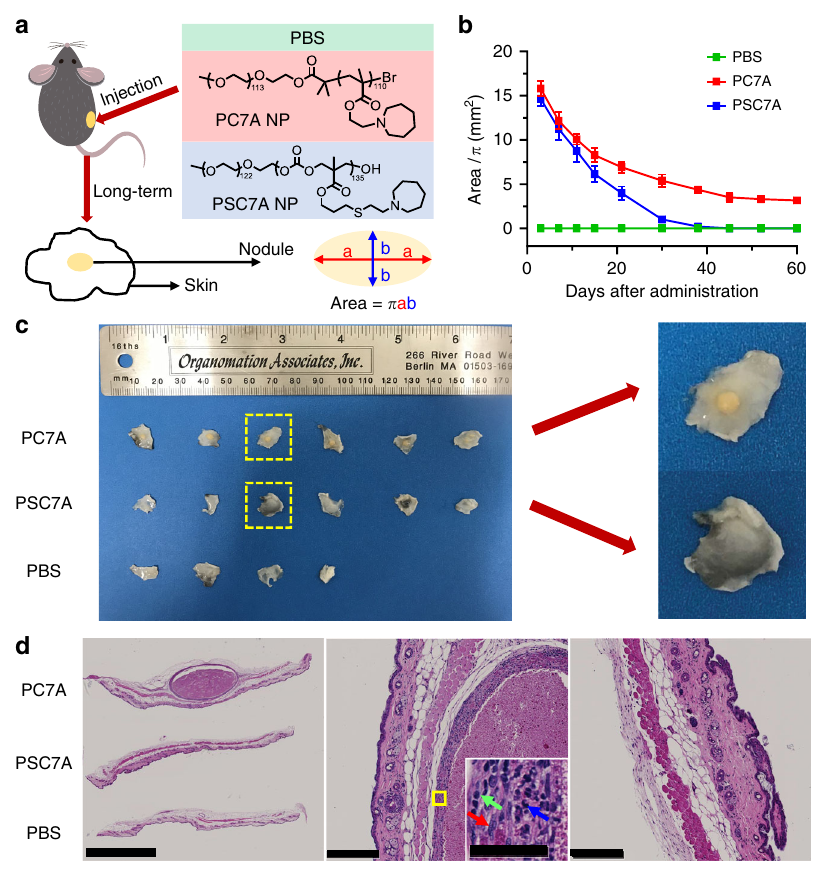
Fig. 7 Long-term safety evaluation of degradable PSC7A NP and non-degradable PC7A NP. a C57BL/6 mice were subcutaneously injected with PBS, 300 μ g PSC7A NP, or 300 μ g PC7A NP on the right fl ank. In fl ammatory nodules formed at the injection sites in PSC7A NP and PC7A NP groups. The surface areas of the nodules were calculated based on an ellipse model. b Change of nodule surface areas over time. n = 4 biologically independent mouse samples in PBS group, n = 6 biologically independent mouse samples in each PSC7A and PC7A group. Data are presented as means ± s.e.m. c Left: photographs of skin tissues taken from the injection sites on day 60, from top to bottom are mice treated with PC7A NP, PSC7A NP, and PBS. Right: magni fi cation of skin tissues from PSC7A and PC7A groups. d Left: H&E staining of formalin- fi xed, paraf fi n-embedded skin tissues (injection sites) on day 60, from top to bottom are mice treated with PC7A NP, PSC7A NP, and PBS. Scale bar: 2.5 mm. Middle: magni fi cation of a nodule surrounded by granulomatous in fl ammation from PC7A group. Scale bar: 250 μ m. Inset: magni fi cation of the area marked by yellow square. The red, green, and blue arrows represent the macrophage, lymphocyte, and neutrophil, respectively. Scale bar: 50 μ m. Right: magni fi cation of skin tissue from PSC7A group. Scale bar: 250 μ m. The whole set of experiment was repeated twice with similar results. In each experiment, two biologically independent mice were chosen randomly from each group on day 60. Skin tissues were harvested from each mouse and three adjacent sections of each sample were taken. One representative image from each group was